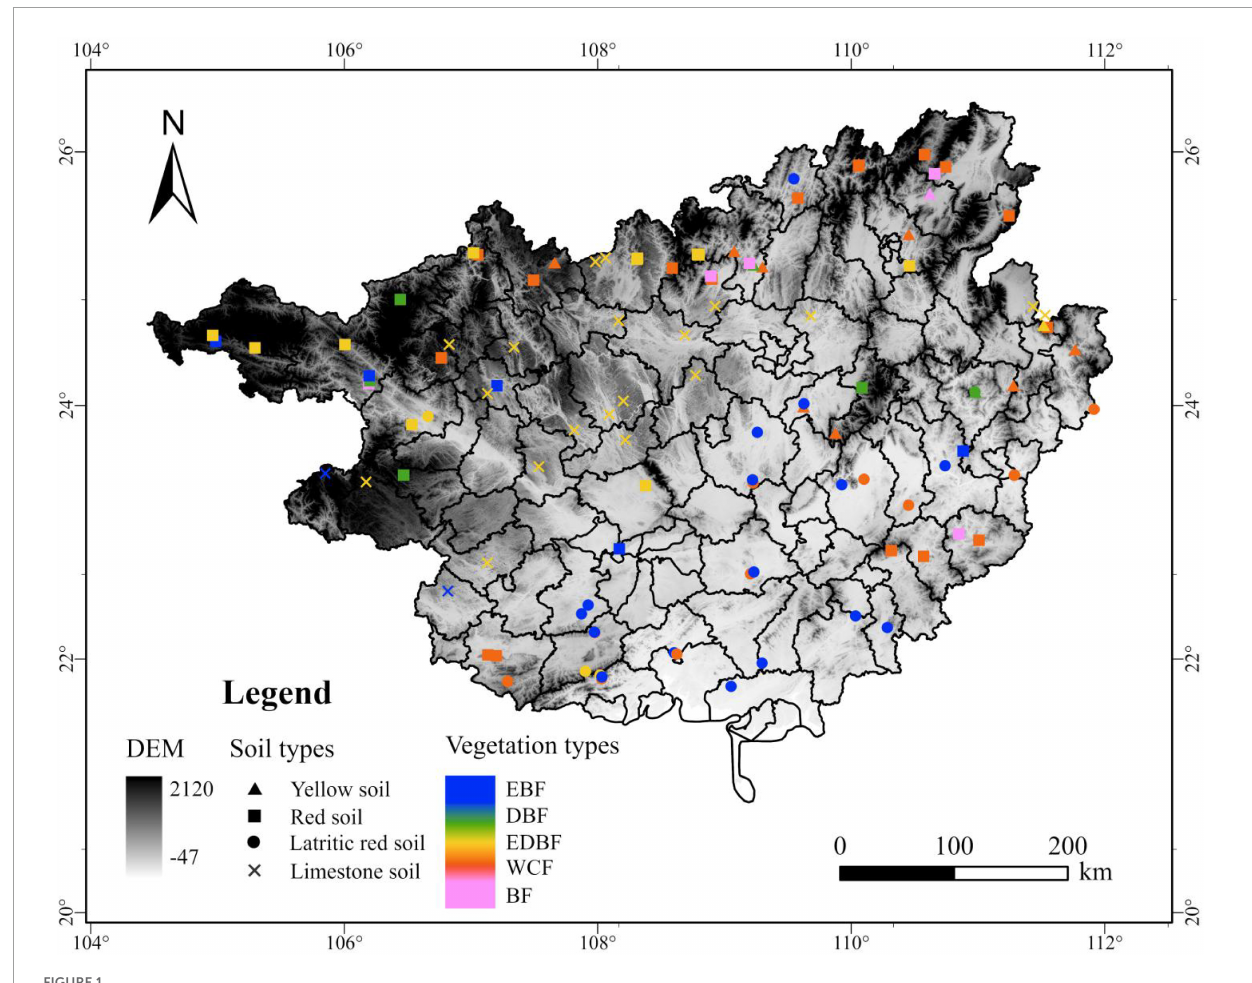
FIGURE1 Sampling sites arrangement diagram of study